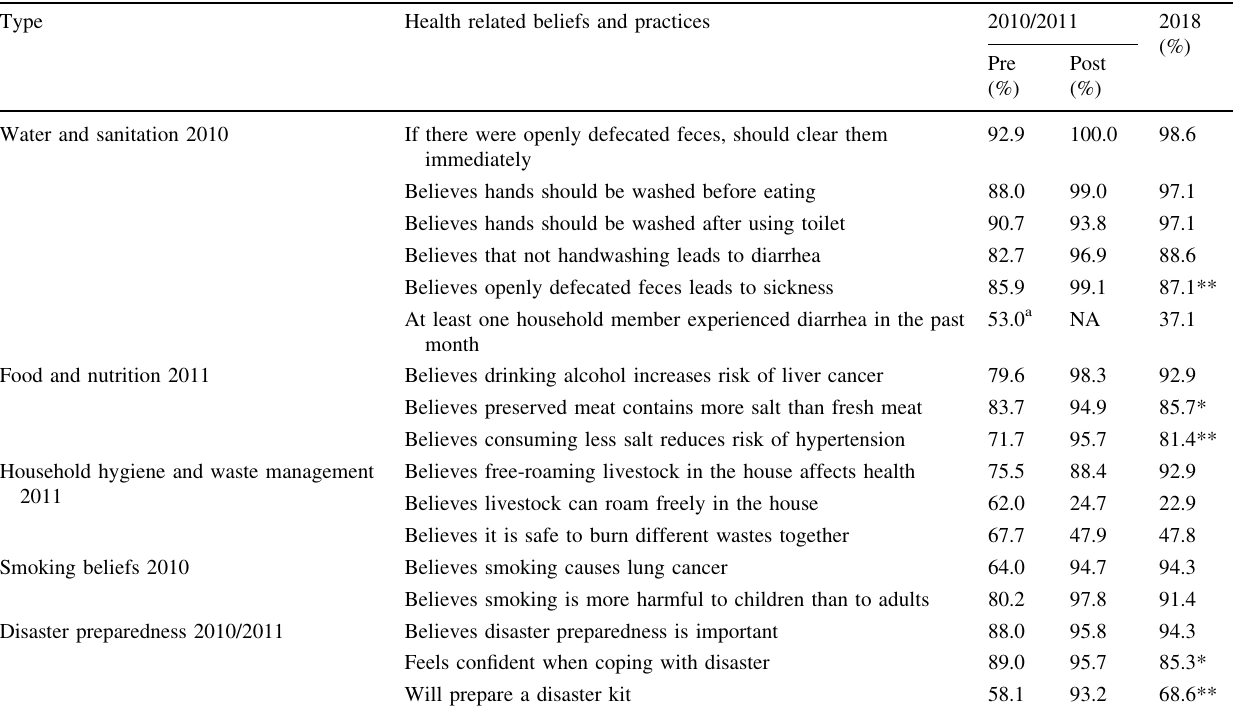
Table 2 Self-reported health-related beliefs and practices in Ma’an Qiao Village during the 2010/2011 pre- and post-intervention and the 2018 evaluation survey